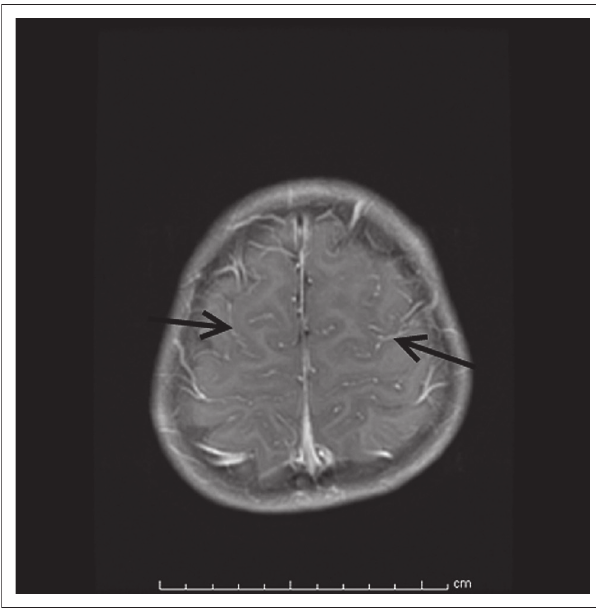
MRI, magnetic resonance imaging. FIGURE 1: Post-contrast T1-weighted MRI demonstrating the ivy sign, namely diffuse leptomeningeal enhancement (arrows) resembling ivy creeping on stone.